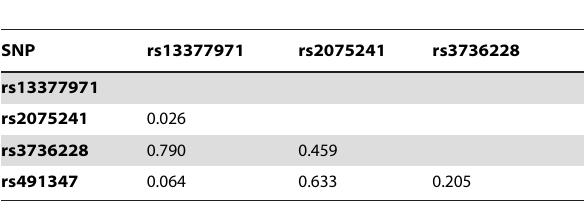
Table 4. Assessment of gene-gene pair-wise interactions.